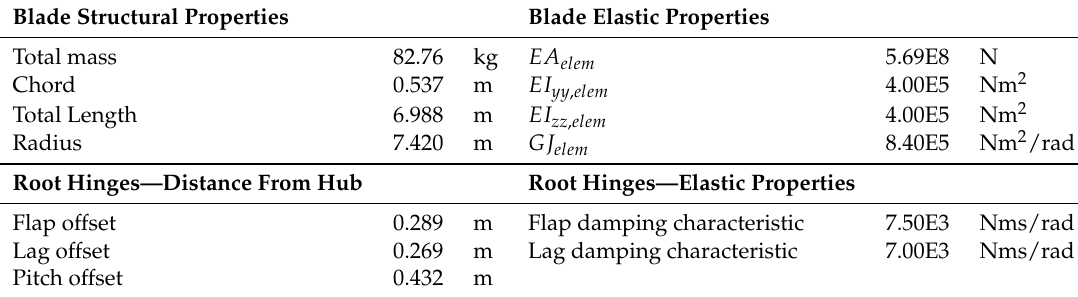
Table 1. Blade and rotor